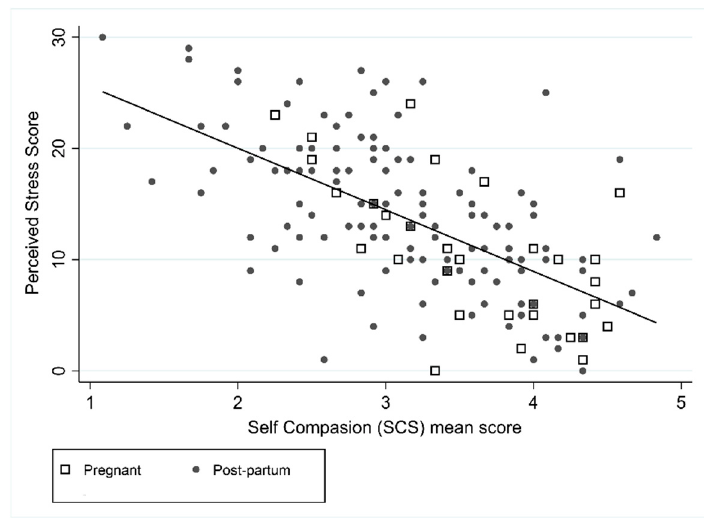
Figure 3. Association between PSS and SCS.